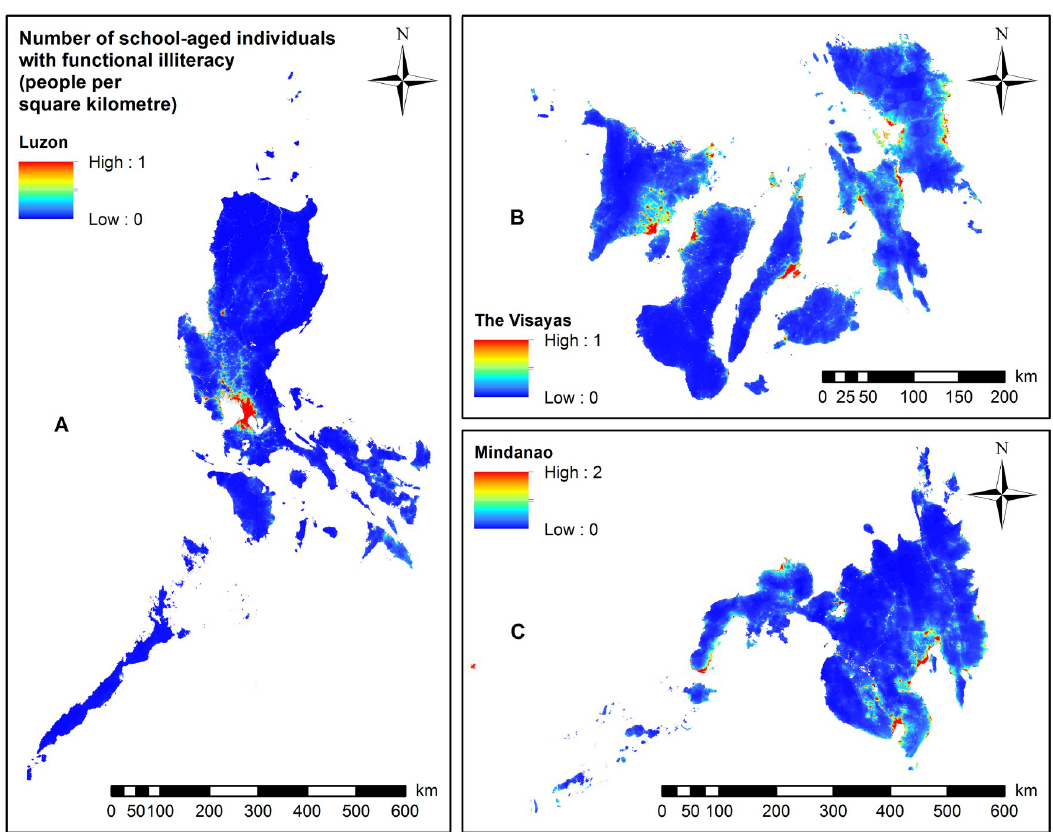
Fig 2. Maps showing the total number of school-aged individuals with functional illiteracy, 2017. (A) Luzon (Results based on Model 3). (B) The Visayas (Results based on Model 3). (C) Mindanao (Results based on Model 5).